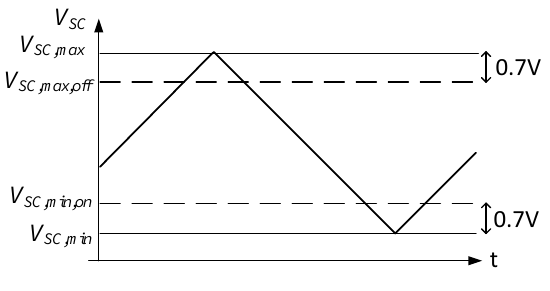
Fig. 4. Schematic of the SC working voltage range.